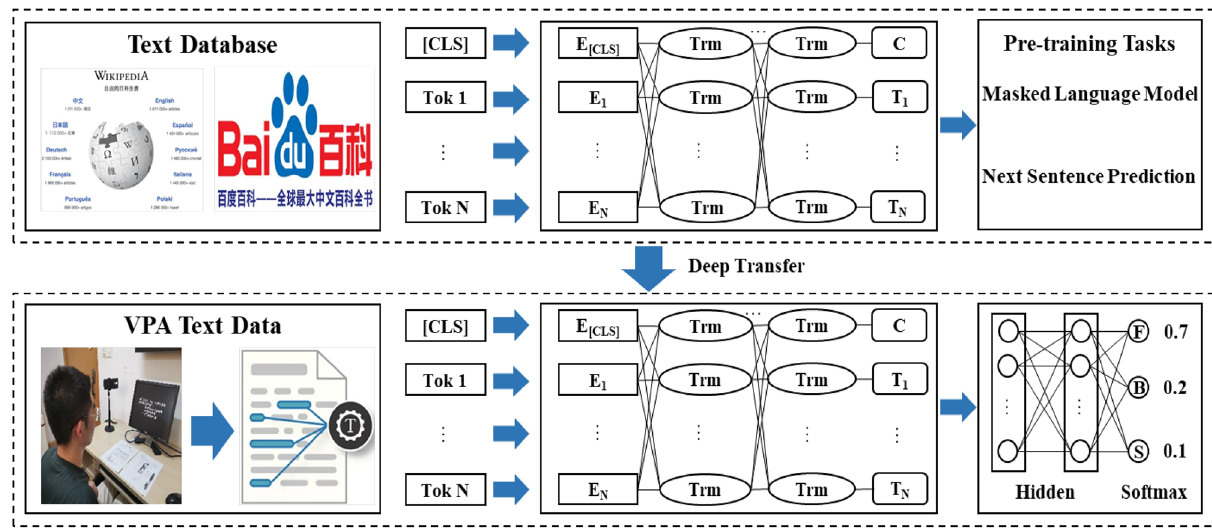
Figure 2. The implementation process of customer requirements classification based on